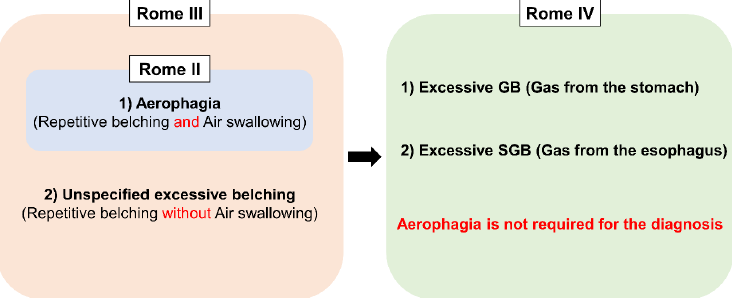
Figure 3. Conceptual change of Belching disorders and Aerophagia in Rome diagnostic criteria. GB; gastric belching, SGB; supragastric belching.